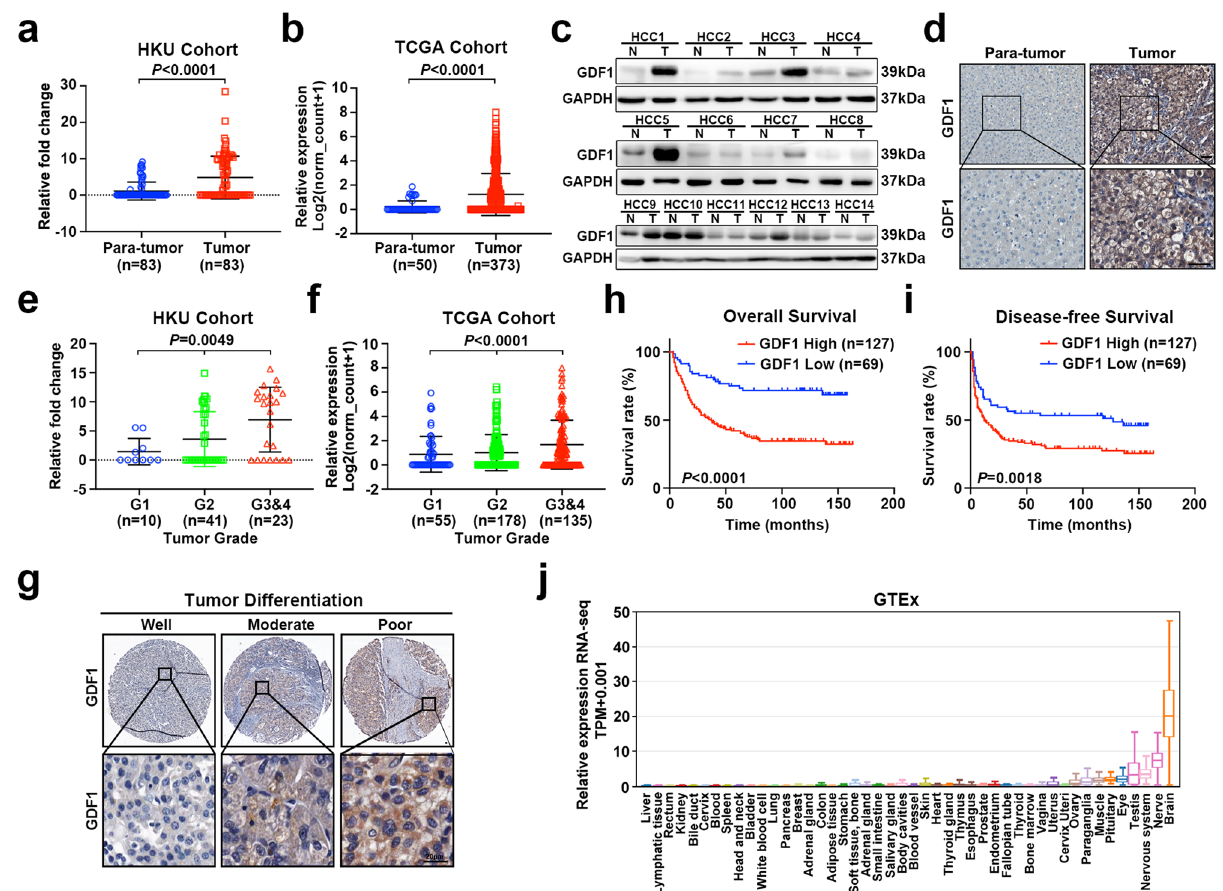
Fig. 1 The expression and clinical signi fi cance of GDF1 in HCC. a The relative mRNA expression of GDF1 was detected by qPCR in the HKU cohort, which included 83 HCC tissues and their paired nontumor liver tissues (two-tailed paired-sample t- test, data are presented as mean values± SD). b The relative mRNA expression of GDF1 was measured by qPCR in the TCGA cohort, which included 373 HCC patients and 50 paratumor liver tissues (two-tailed independent Student ’ s t -test, data are presented as mean values ± SD). c The relative expression of GDF1 at the protein level was measured by western blot in representative HCC tissues and their paired nontumor liver tissues ( n = 3 independent experiments). d IHC staining of GDF1 in representative HCC tissue and paired nontumor liver tissue ( n = 3 independent experiments). e The relative mRNA expression of GDF1 was measured by qPCR in subgroups of patients with different tumour grades in the HKU cohort (one-way ANOVA, data are presented as mean values ± SD) f and in the TCGA cohort (one-way ANOVA, data are presented as mean values ± SD). g IHC staining of GDF1 in representative poor-, moderate-, and well-differentiated HCC tumours in a tissue microarray (TMA) containing 196 liver tumour tissues. h, i Kaplan – Meier analysis indicated that the high expression of GDF1 was signi fi cantly correlated with poor overall survival ( h ) and disease-free survival ( i ) of HCC patients (log-rank test). j The expression of GDF1 was examined in a panel of normal tissues from the GTEx database (17,382 RNA-seq across 54 tissue sites and two cell lines). Boxes represent quartiles, centre lines denote 50th percentile, and whiskers extend to most extreme values. Scale bars represent 20 µ m. Source data are provided as a Source Data fi